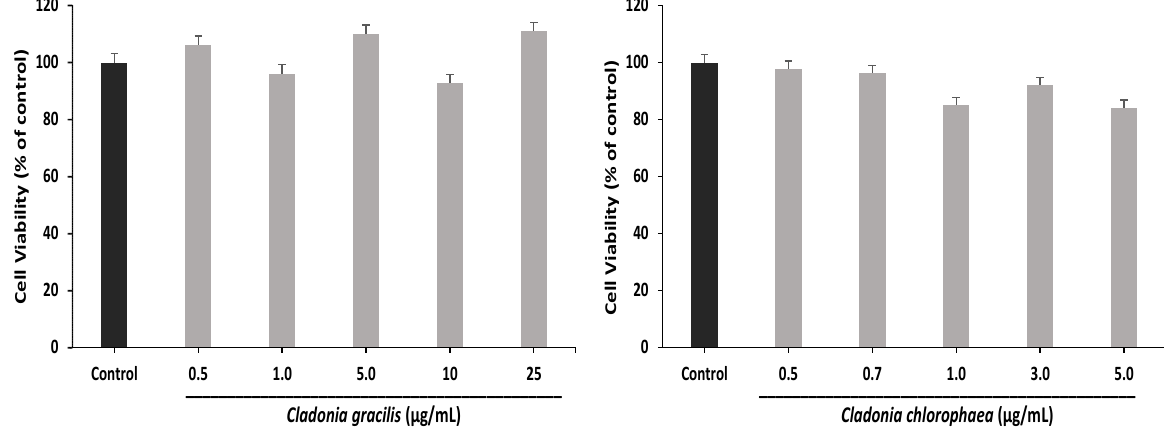
Figure 8. Effect of C. gracilis and C. chlorophaea extracts on viability in the SH-SY5Y cell line. The values represent the means ± SD of three replicates (n = 3).